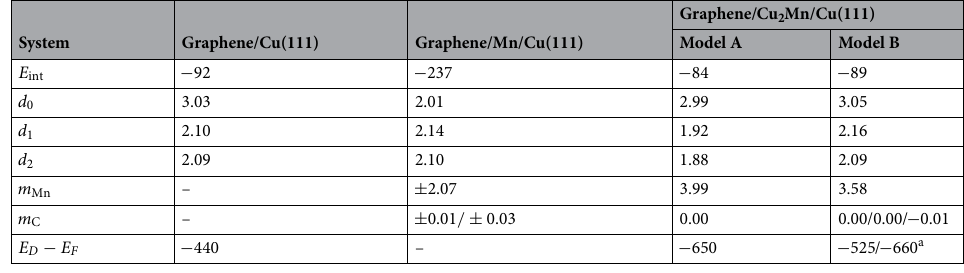
Table 1. Results for the atomic structure of the graphene/metal interface models and for the clean metal ( E gr E gr / metal E metal ) , where surfaces: E int (in meV/C-atom) is the interaction energy, defined as E int = − + E gr / metal is the total energy of the graphene/metal system, and E gr and E metal are the energies of the fragments at the same coordinates as in the graphene/metal system; d 0 (in Å) is the mean distance between the graphene overlayer and the interface metal layer; d 1 (in Å) is the mean distance between the interface metal layer and the second metal layer; d 2 (in Å) is the mean distance between the second and third metal layers; m Mn ( µ B ) is the interface Mn spin magnetic moment; m C (in µ B ) is the interface carbon spin magnetic moment (several values E F (in meV) is the position of the Dirac point with for the nonequivalent carbon atoms are indicated); E D − a respect to the Fermi energy. Two values are given for the spin-up and spin-down channels, respectively